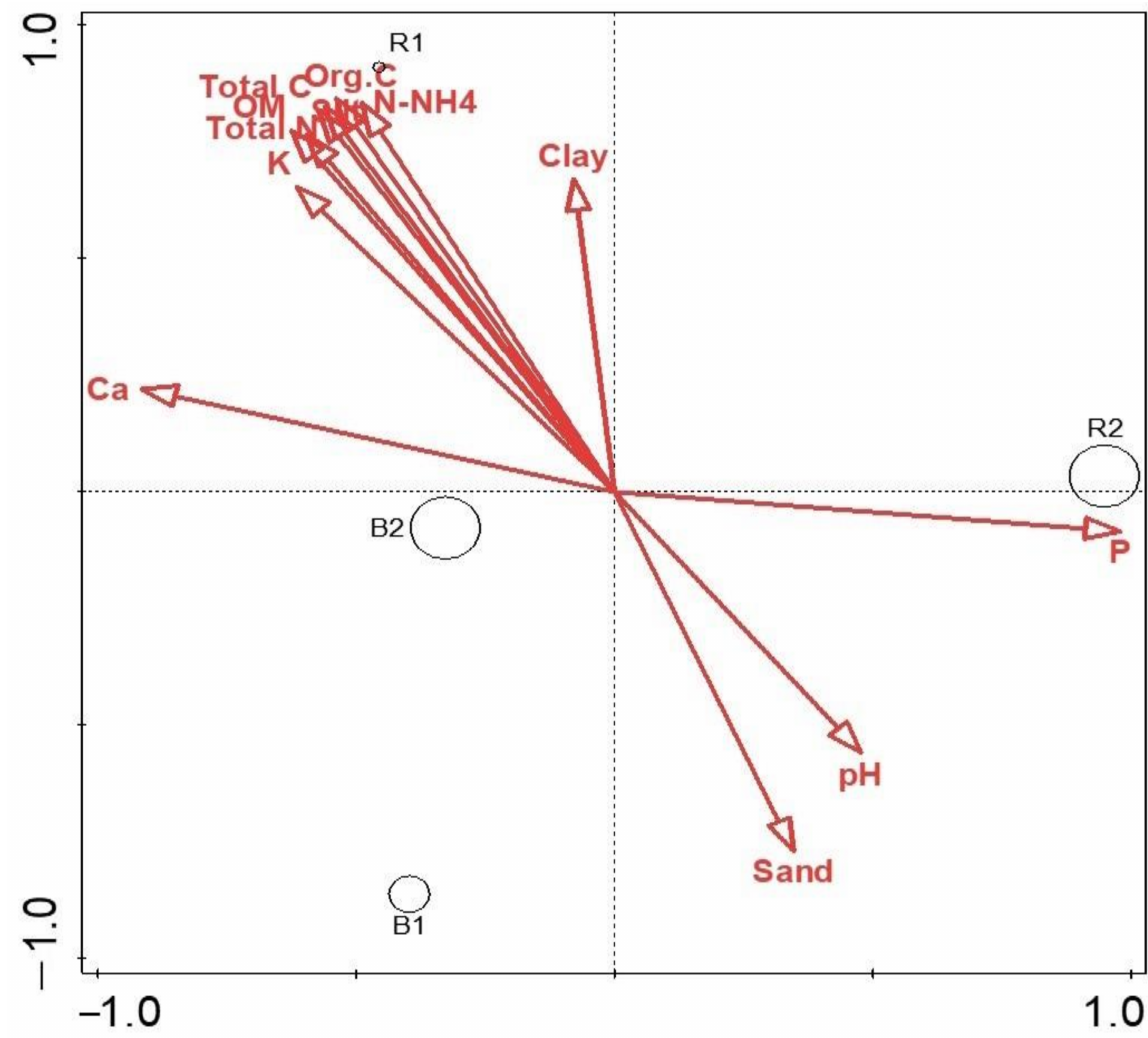
Figure 9. Canonical correspondence analysis (CCA) of the major soil chemical parameters based on soil types (R1, R2, B1, B2) explaining the combined variation of